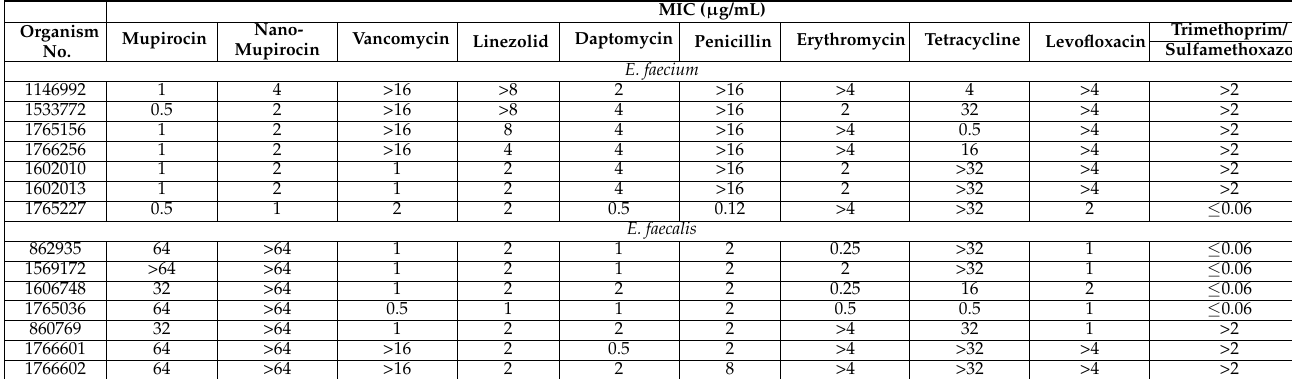
Table 4. Mupirocin and Nano-mupirocin MICS for E. faecium and E. faecalis